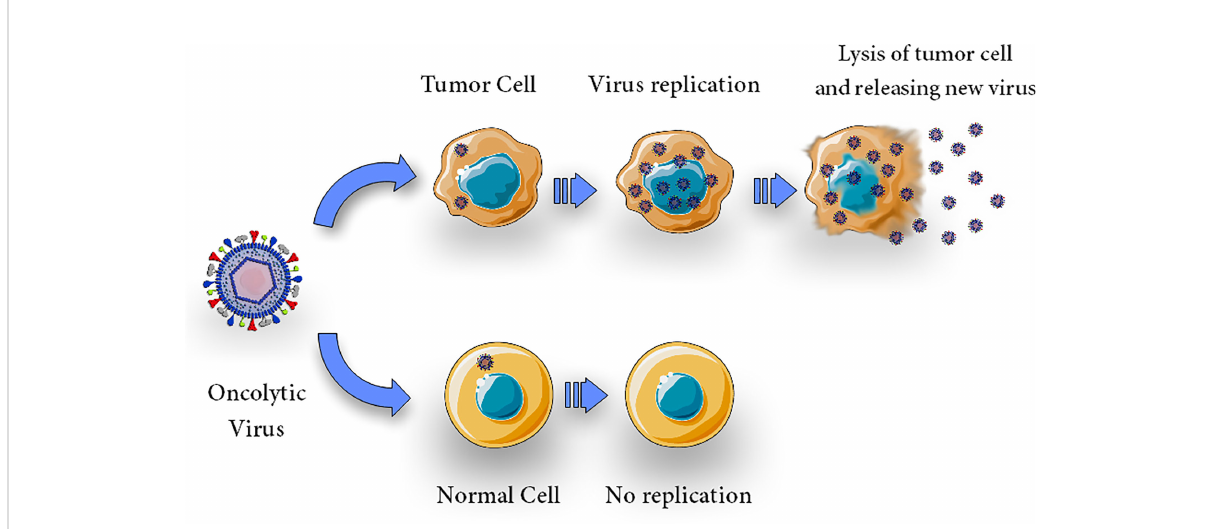
FIGURE 1 Direct cytolytic activity. Oncolytic virus can selectively infect, replicate, lyse and kill cells. Upon infection with an oncolytic virus, the oncolytic virus replicates in tumor cells and causes oncolysis but does not harm normal